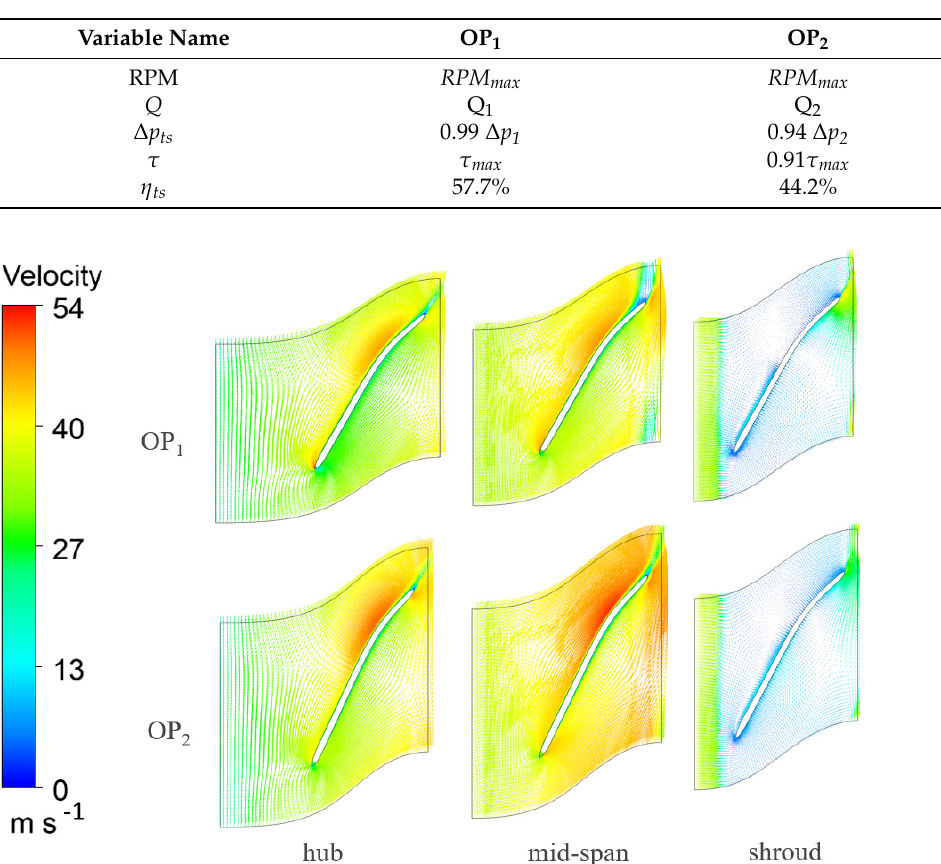
Figure 8. Baseline relative velocity vector at OP 1 and OP 2.